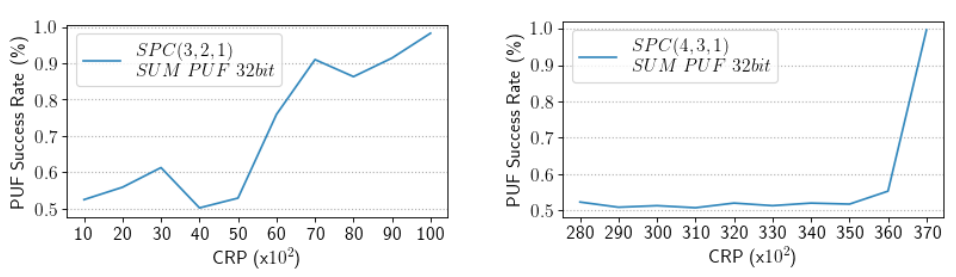
Figure 8: PUF success rate of two attacks on a 32-SUM PUF while utilizing XOR-equations with κ = 3 of the SPC(3 , 2 , 1) and κ = 4 of the SPC(4 , 3 , 1) code. XOR-equation has a significant influence on the number of CRP s needed to predict a PUF